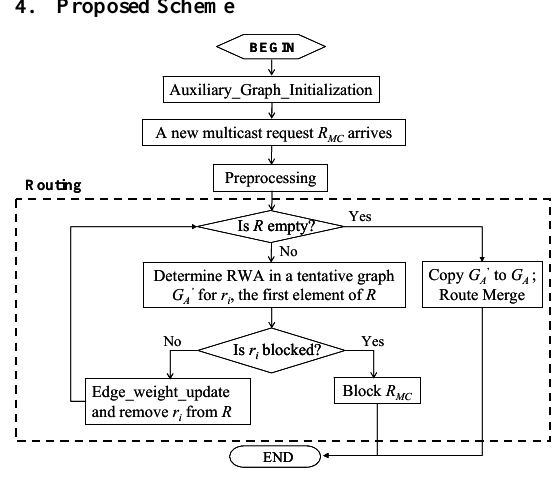
Fig. 4. The flowchart of